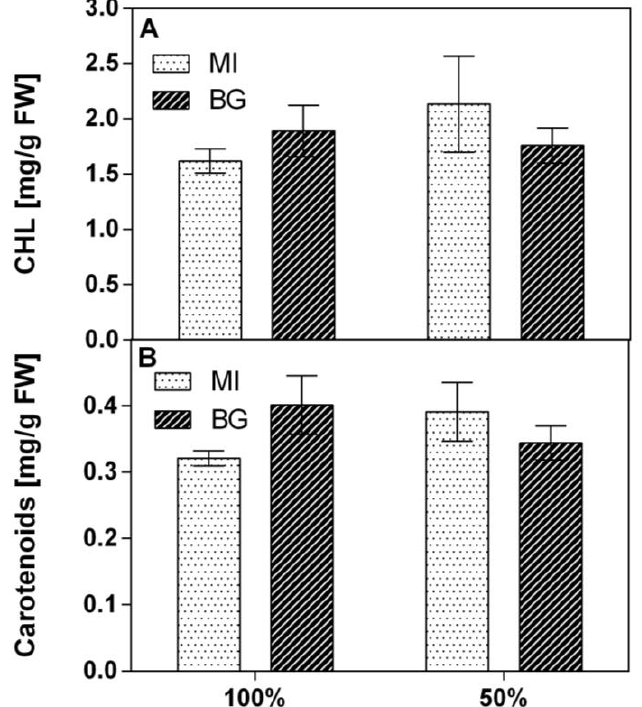
Figure 1. Total chlorophyll ( A ) and total carotenoids ( B ) in fresh leaves of two wild hedge mustard populations, MI and BG, cultivated under different water availability (100% and 50%). Values are means with standard errors (n = 3). Data were subjected to two-way ANOVA, and no significant differences were found. Table 1. Water reduction (WR): 100% water availability and 50% water reduction and its effect on maximum quantum efficiency (Fv/Fm), performance index (PI), dissipation of energy across reaction centers (DIo/RC), reaction centers per cross-section at Fm (RC/CSm), and electron flux per reaction center